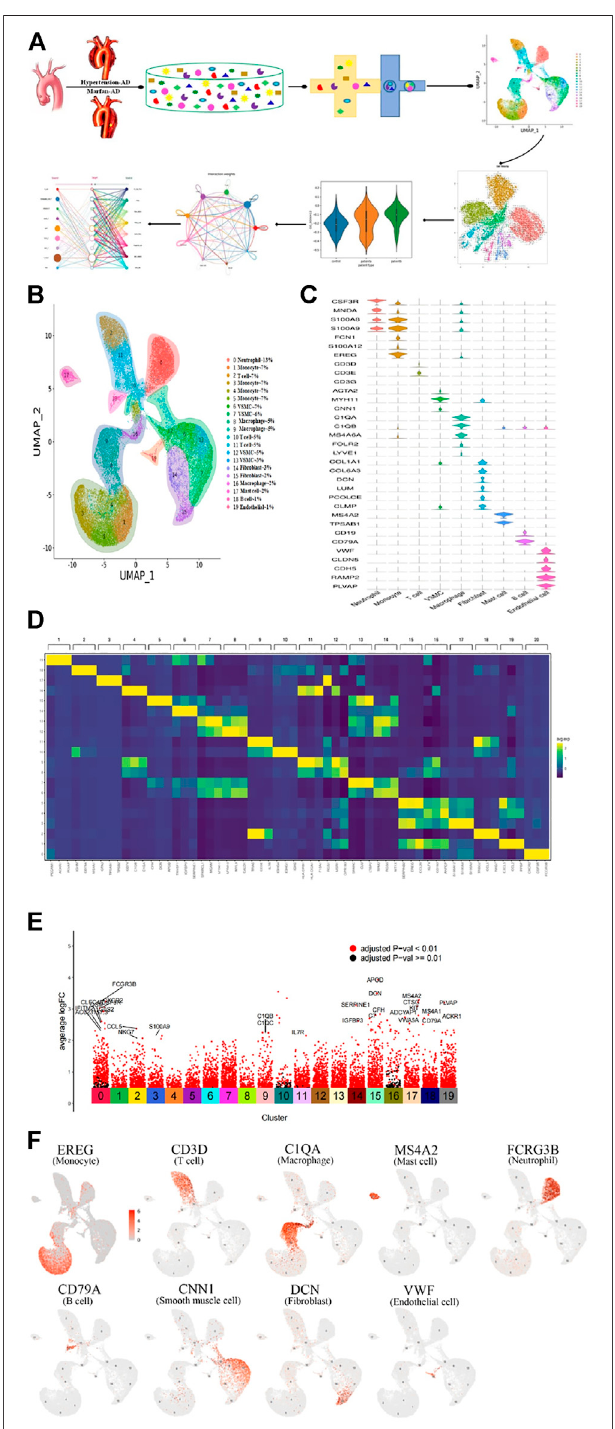
FIGURE 1 | Single-cell RNA sequencing analysis reveals cellular heterogeneity in hypertension and Marfan-induced aortic dissection (AD). (A) The schematic fi gure for tissue collection, cell digestion, procession, isolation, and capture by the BD device, and then data analysis. (B) 20 distinct clusters of cells were identi fi ed and color-coded and are exhibited in the UMAP plot, showing the cellular heterogeneity. Different cell identities and